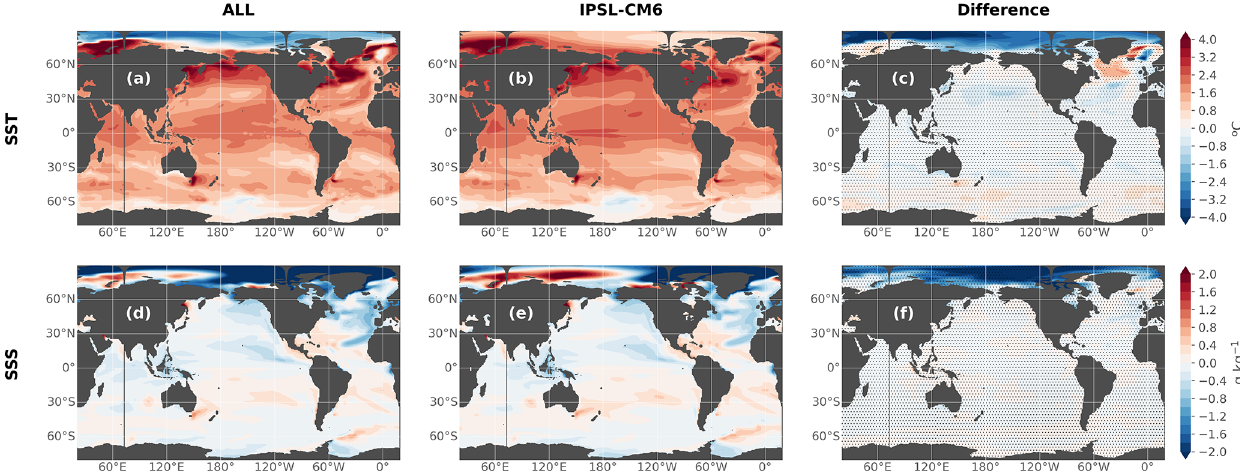
Figure 12. Same as Fig. 11 but for sea surface temperature (a–c) and salinity (d–f)